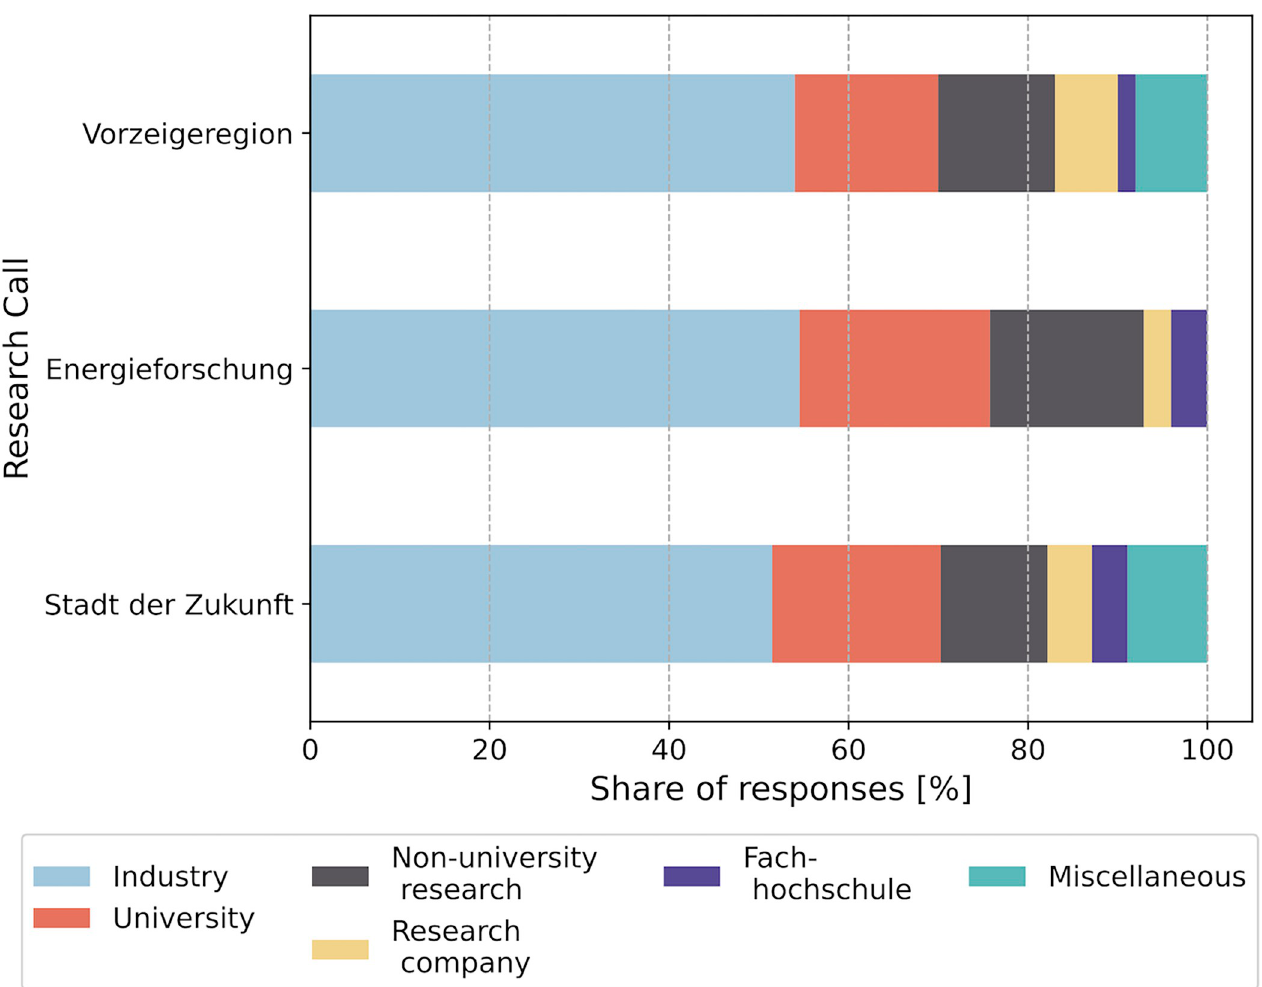
Fig 2. Composition of projects for the research calls Stadt der Zukunft (average for the years 2019, 2020, 2021), Energieforschung (average for the years 2017, 2018, 2019, no data were available for the years 2020 and 2021.), and Vorzeigeregion.